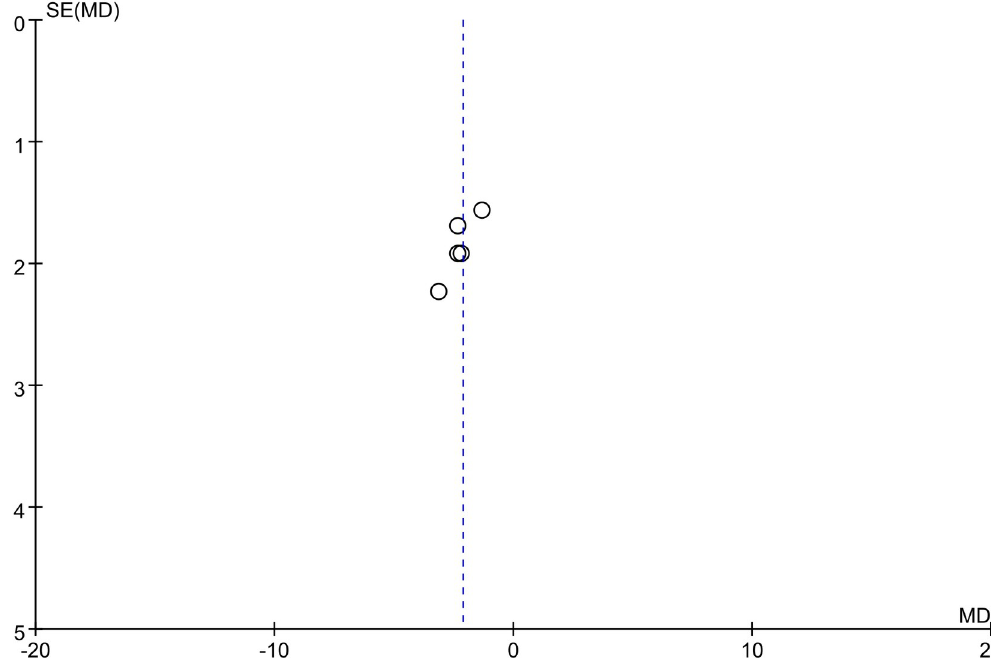
Fig 4. Funnel plot for outcomes of changes in diastolic blood